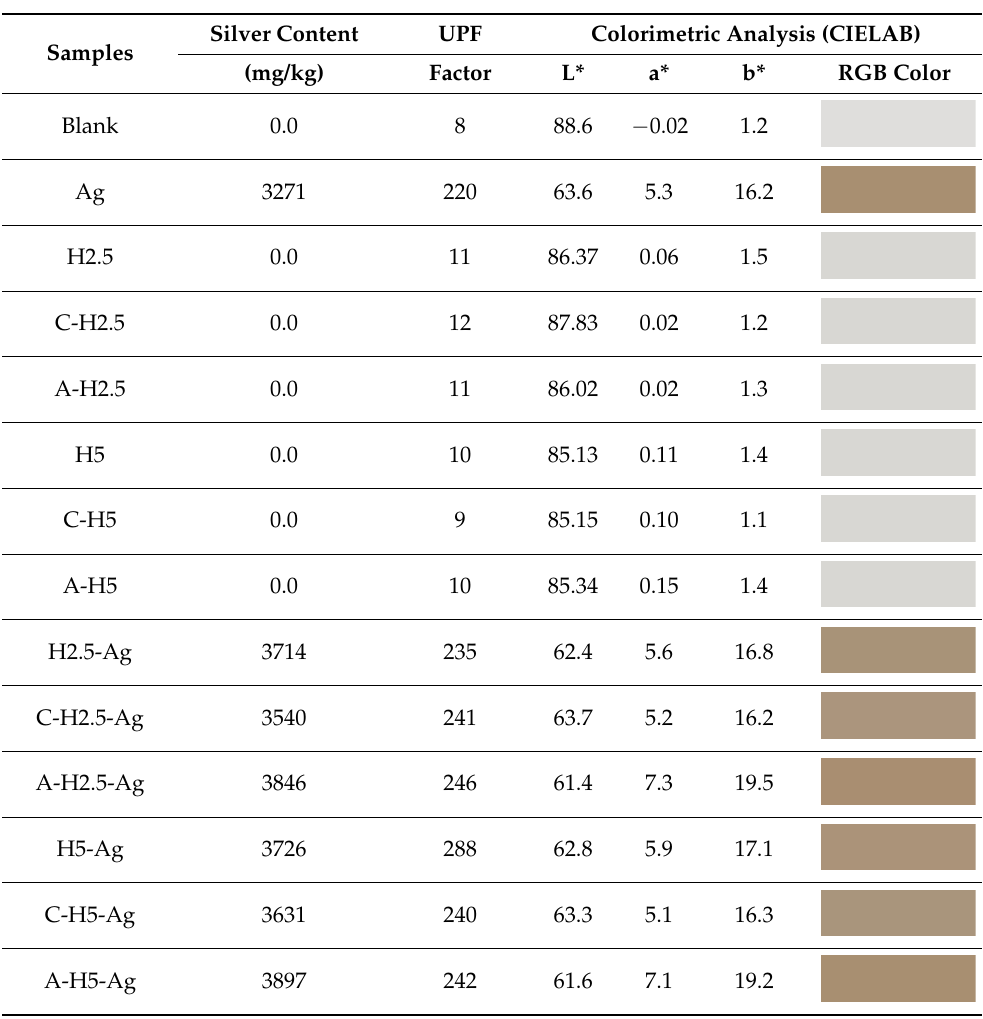
Table 2. Silver (absorption spectrophotometry (AAS)), Ultraviolet Protection Factor (UPF) (UV–vis spectrophotometry), and colorimetric analysis (According to Color Matching System CIE 1976 L*, a*, b* color space) of the indicated cotton gauze samples after washing and